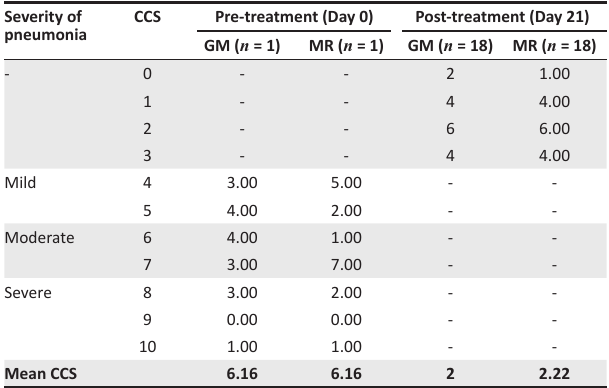
TABLE 3: Pre- and post-treatment cumulative clinical scores in both groups of kids with acute pneumonia. Severity of CCS Pre-treatment (Day pneumonia